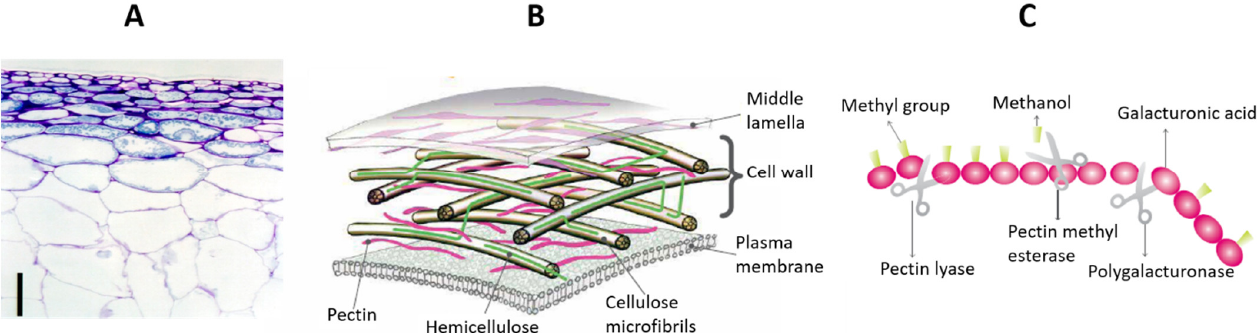
Figure 7. ( A ) Microscopy of the grape berry skin (bar = 200 µ m); ( B ) Grape cell wall consisting mainly of cellulose, hemicellulose, and pectin; ( C ) Diagram indicating where the main pectinases (pectin lyase, pectin methylesterase, and polygalacturonase) act on the cell-wall pectin chain.